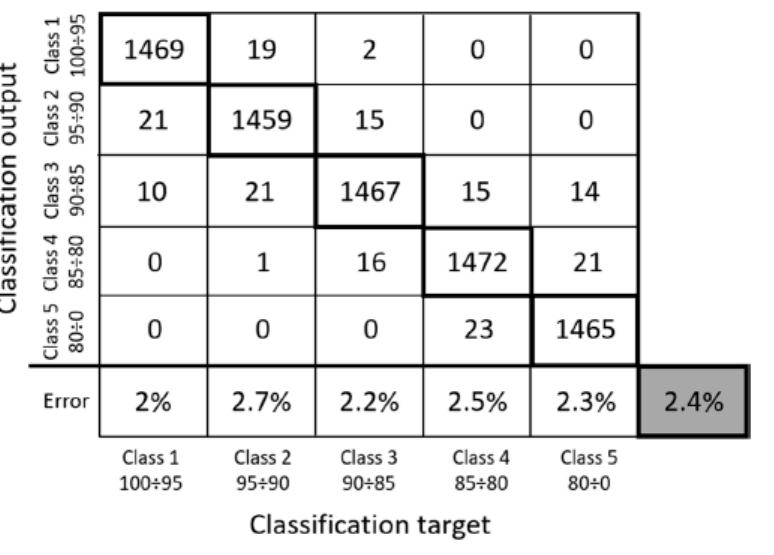
Figure 14. Confusion Matrix for SOH